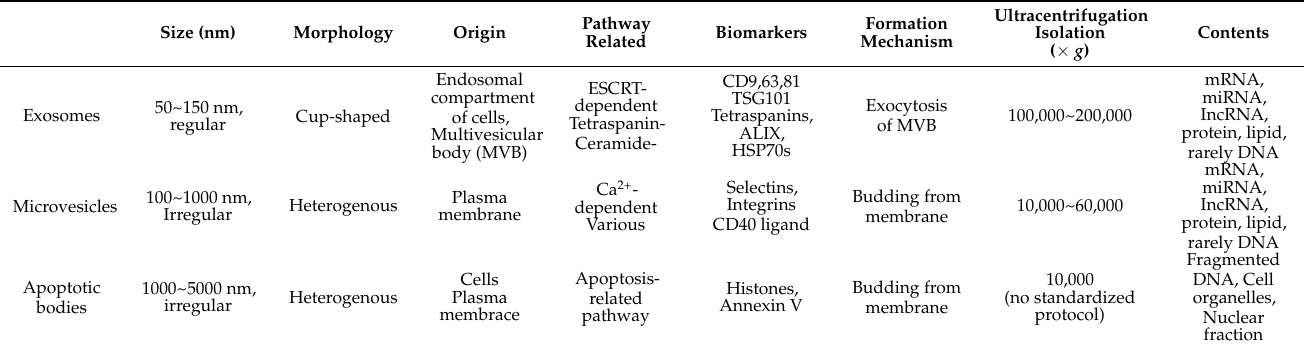
Table 1. Summary of details for exosomes, microvesicles, and apoptotic